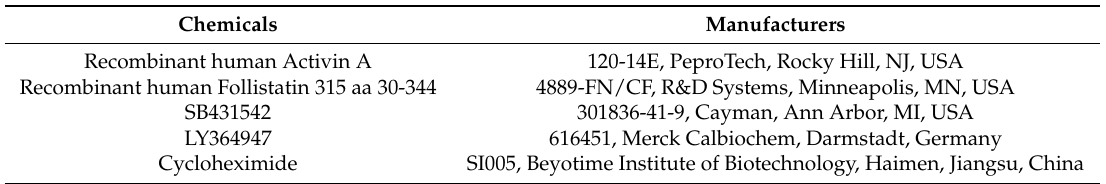
Table 1. Cytokines, kinase inhibitors and other chemicals used in this